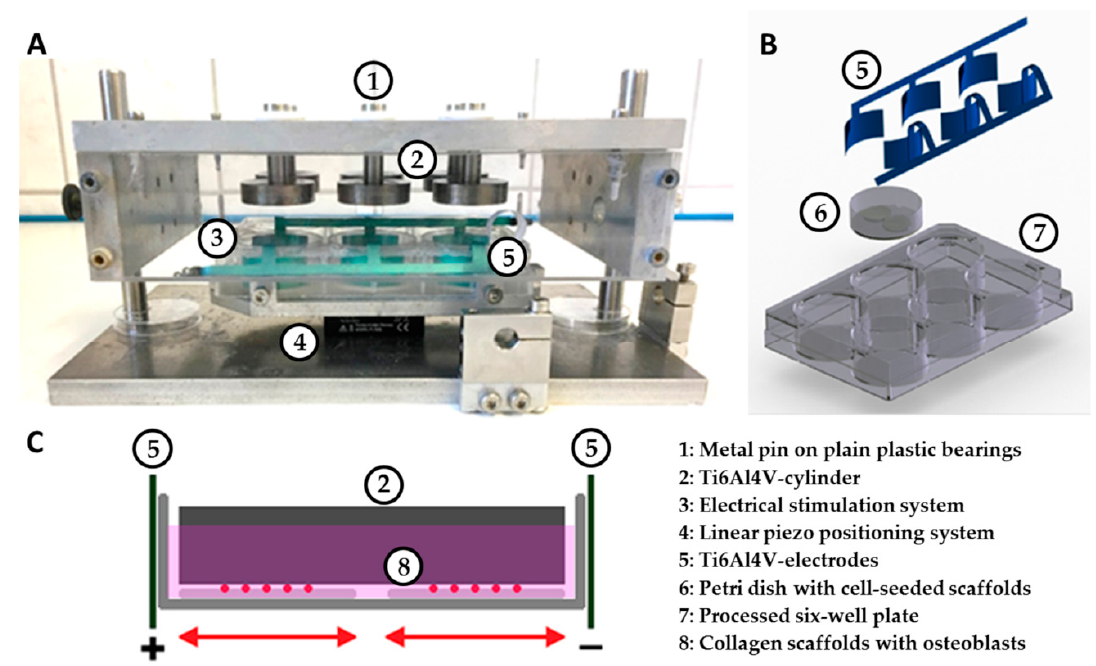
Figure 1. Overview of the components of the stimulation device. ( A ) System for the simultaneous application of capacitively coupled alternating electric fields and harmonically oscillating micromotions on cell-seeded scaffolds. The electrical stimulation system was fixated on top of a linear piezo positioning system using a special rack. The lid of the system holds titanium–aluminum–vanadium alloy (Ti6Al4V) bodies resting on plain plastic bearings on metal pins. ( B ) 3D representation of the individual components of the electrical stimulation system. ( C ) Systematic drawing of two scaffolds with osteoblasts in a petri dish filled with medium. The dish is incorporated into the electrical stimulation system (two Ti6Al4V electrodes), which is moved by the linear positioning system relative to a static Ti6Al4V cylinder.